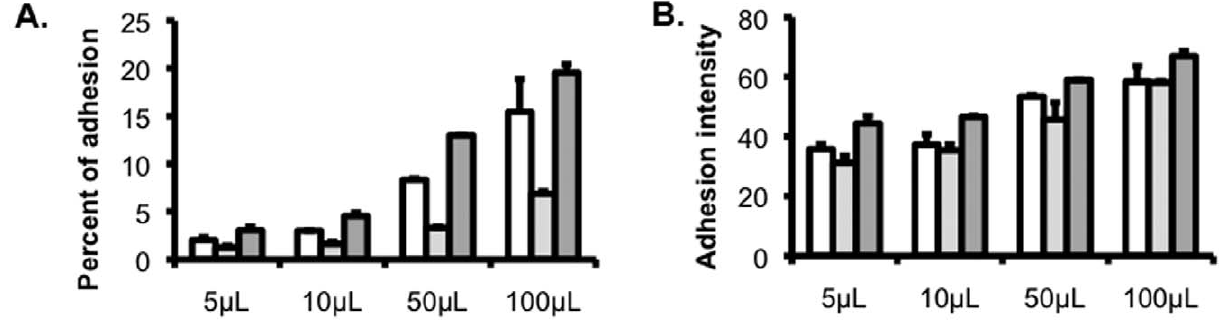
Figure 2. Adhesion level and intensity. Vesicles were prepared from three different placentas (denoted by the white, light grey and dark grey bars) and adjusted to the same density. Increasing volumes of these vesicles (5 to 100 m L) were incubated with the placental-type line CS2. ( a. ) Despite the similar purity and mean fluorescence levels of the various vesicle preparations, the percentage of IE with adherent vesicles varied significantly across vesicle preparations and increasing the volume of vesicles had a strong impact on the adhesion levels associated with some, but not all, vesicle preparations. ( b. ) This difference was not mirrored by differences in adhesion intensity (measured as the PKH67 MFI of vesicle bound- IE), which increased in proportion to vesicle volume for all vesicle preparations. Data are shown as mean and standard deviation from experimental triplicates.